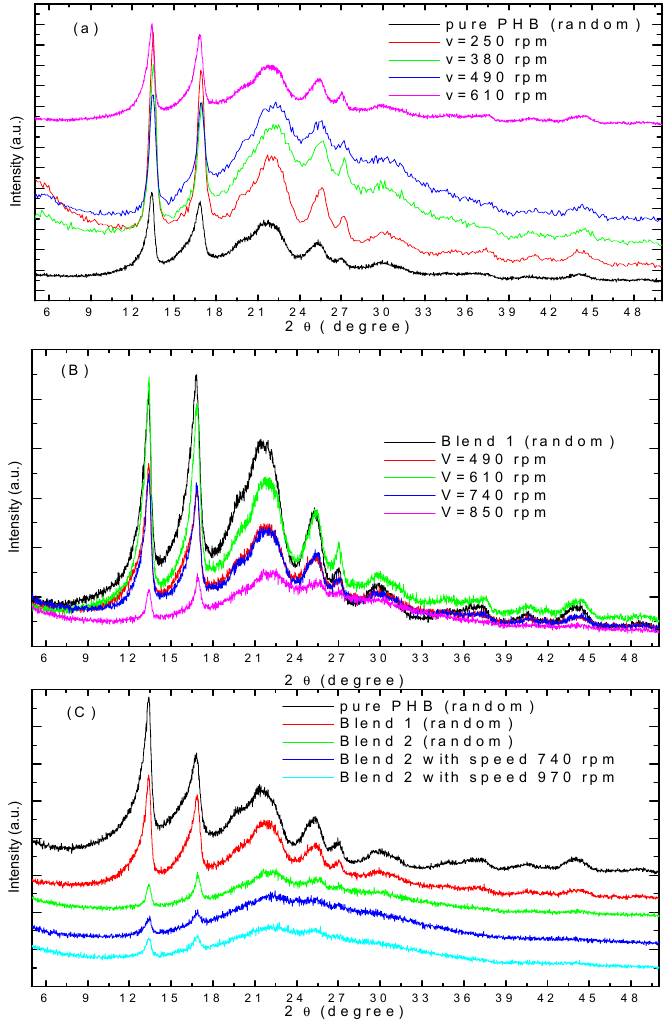
Figure 8. WAXD of electrospun fibers of ( a ) pure PHB with different take-up speeds (v), ( b ) blend 1 with different take-up speeds, and ( c ) pure PHB, blends 1, 2, and blend 2 with different take-up speed (v).